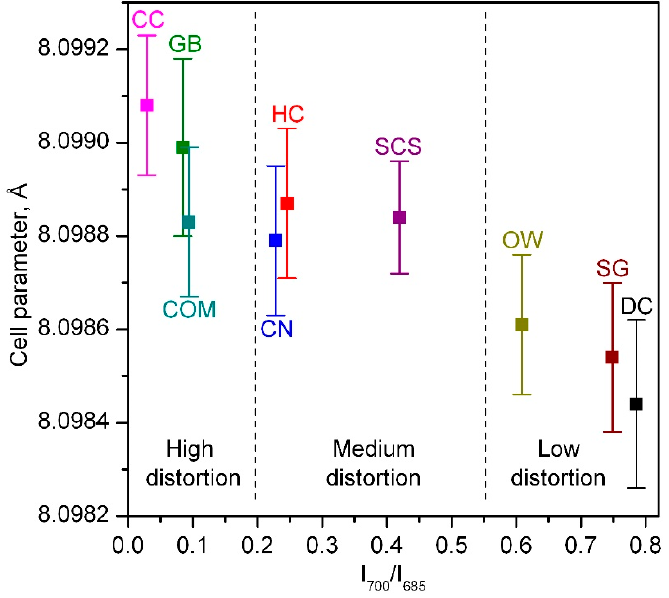
Figure 3. Evolution of the lattice distortion of the bulk Co 3 O 4 catalysts.